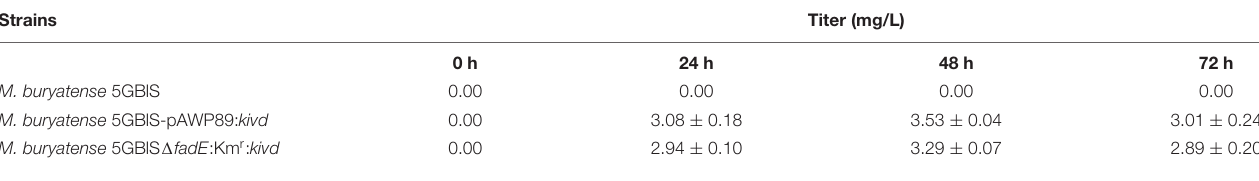
TABLE 2 | Biosynthesis of isobutyraldehyde in the cultures of wild-type ( Methylomicrobium buryatense 5GB1S) and mutant strains.